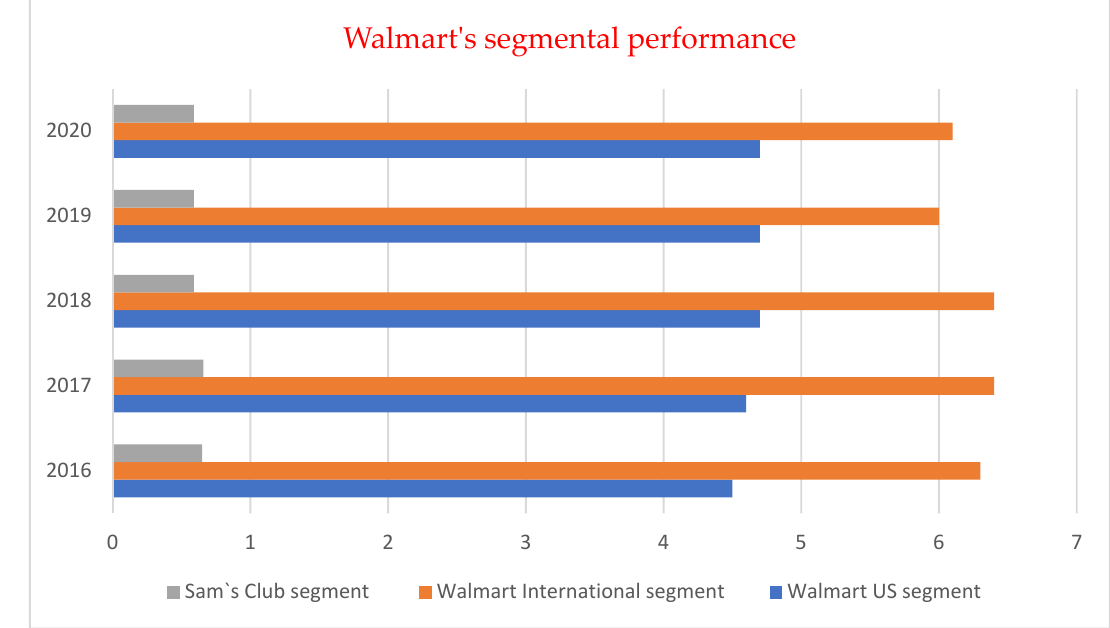
Figure 7. Walmart’s performance by segment.